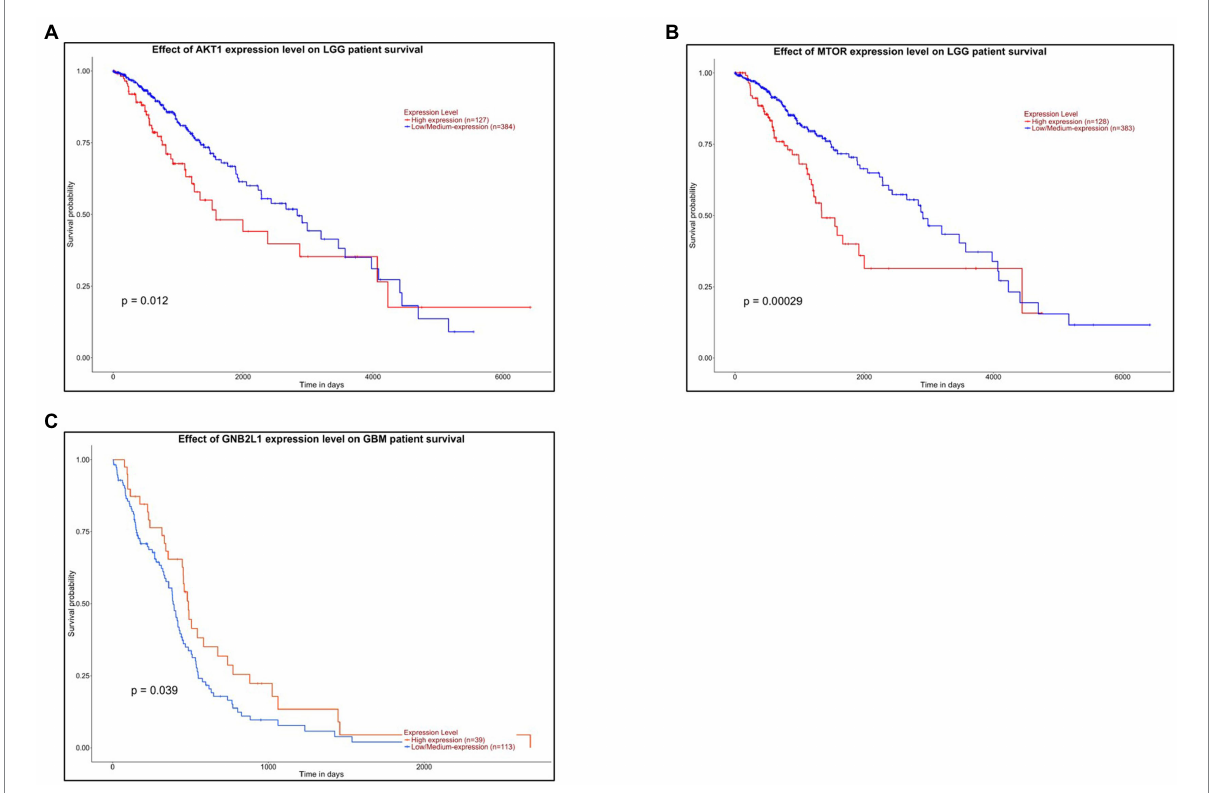
FIGURE 7 Survival Analysis. The Kalpen Meier survival analysis of (A) AKT1 and (B) MTOR gene in LGG cancer patients. (C) The Kalpen Meier survival analysis of GNB2L1 gene in GBM cancer